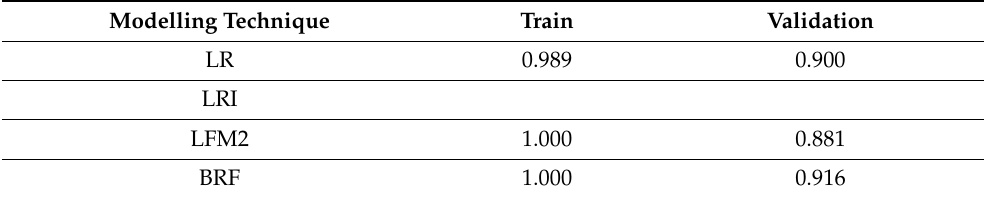
Table 15. F1 scores obtained by the models on the reduced data